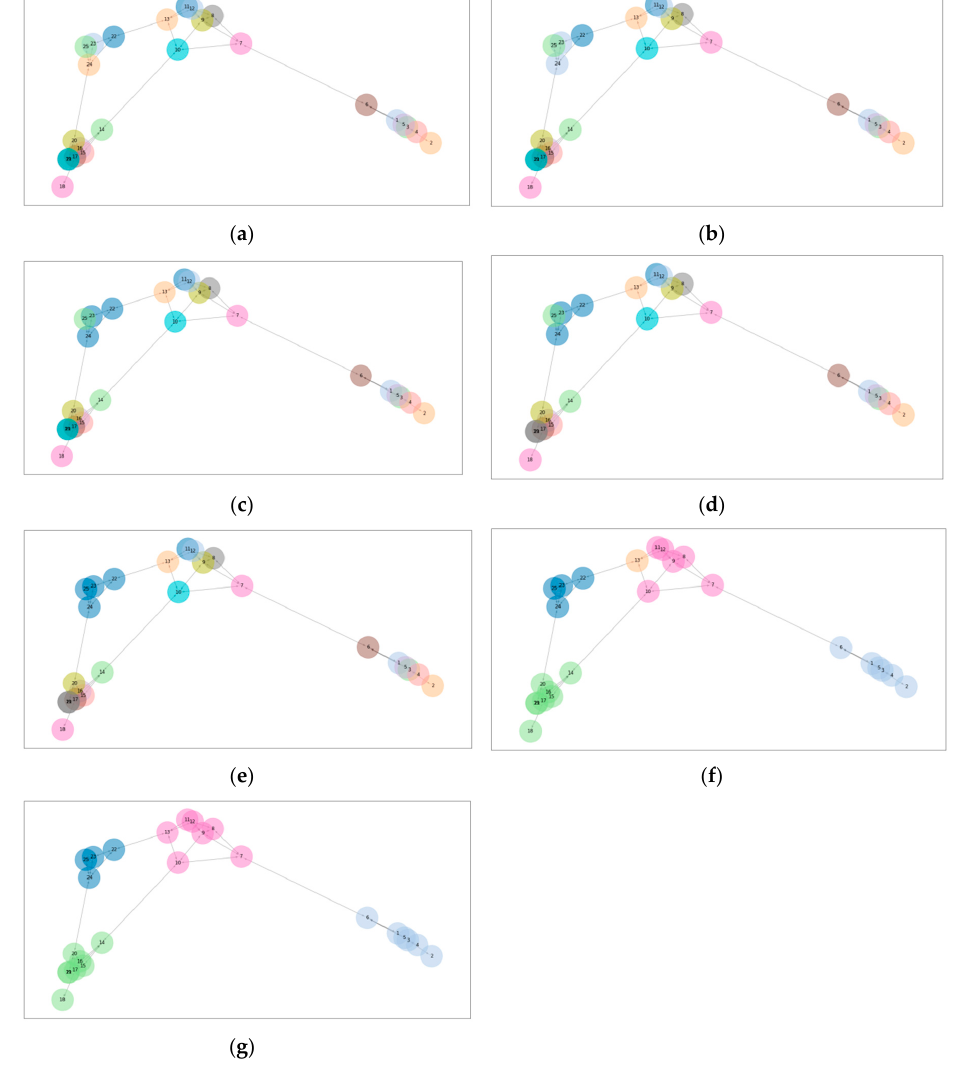
Figure 1. Graph with 25 nodes as visual illustration of InfoMap algorithm. Each node is labeled with a node number for reference and is colored according to its assigned community. We show the first four merges, and last two merges according to the InfoMap algorithm. In each step, two communities are merged into one. There are 21 merges in total. For brevity, only the first four and last two merges are shown. ( a ) In the initial graph, each node is its own module; ( b ) nodes 23 and 24 are merged; ( c ) node 22 is merged with module 23–24; ( d ) nodes 17 and 19 are merged; ( e ) node 25 is merged with module 22–23–24; ( f , g ) for brevity, we skip to the last two merges, where we are left with a final partitioning of four